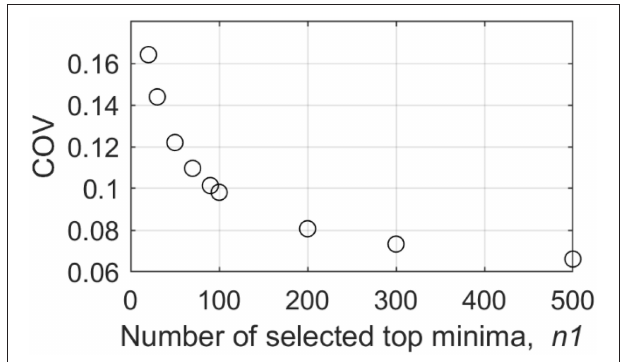
FIGURE 5 | The variation of COV of estimated Cp peak with the number of top minima in